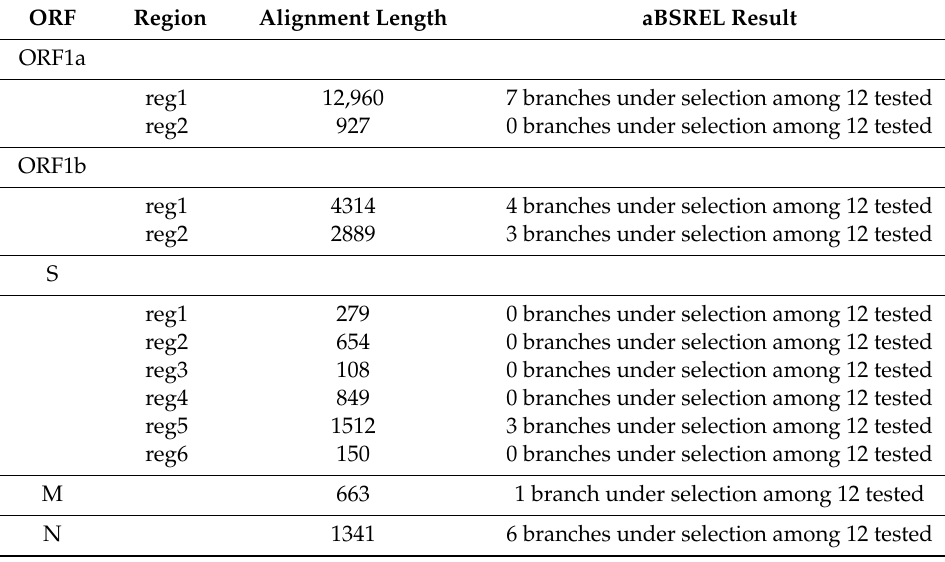
Table 2. Analysis of episodic diversifying selection in merbecovirus ORFs.